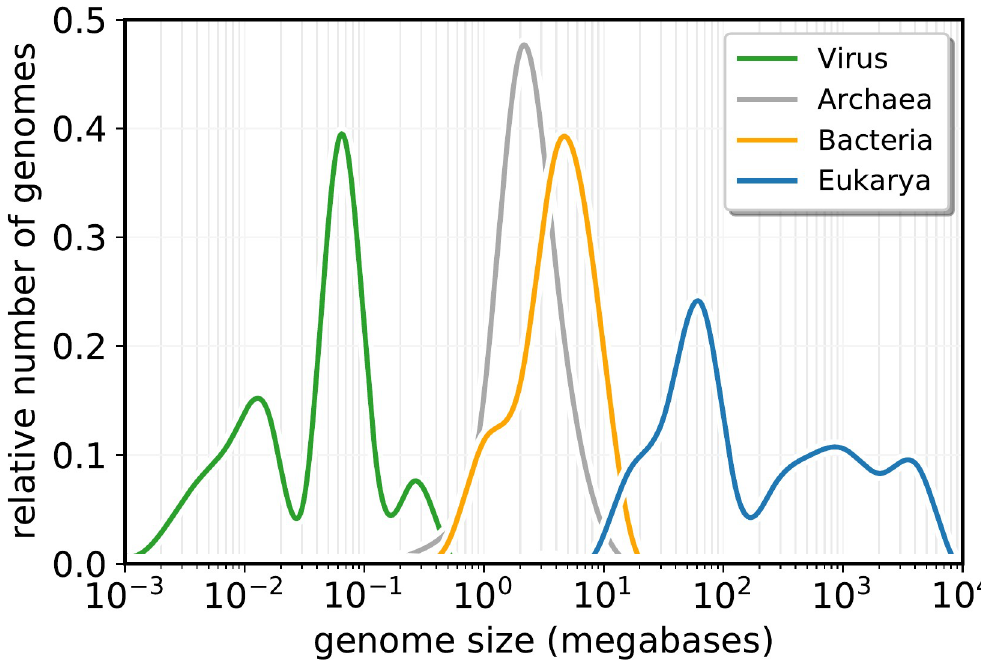
Fig 1. Sizes of completed genome sequences, showing distinct size distributions for prokaryotes (bacteria and archaea), eukaryotes and viruses. X axis: Genome size in megabases, Y axis: Fraction of each of the four classes of organism that have genome of that size. Data from https://www.ncbi.nlm.nih.gov/genome/browse/#!/overview/, accessed 15 th June 2020; based on 27308 bacteria, 1769 Archaea, 5300 Eukarya and 19536 viruses.